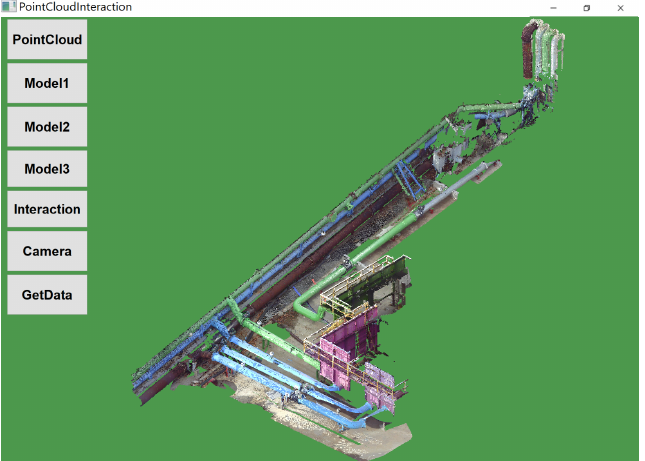
Figure 3. Acquired pre-processed PCD using Trimble